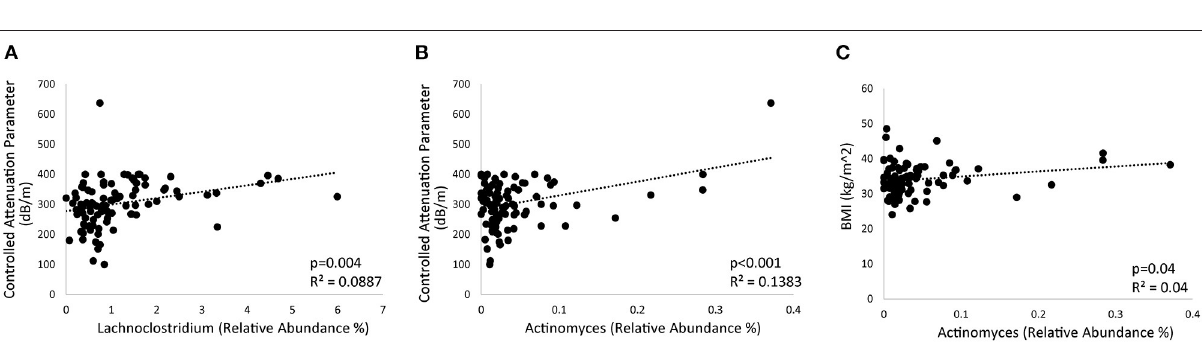
FIGURE 4 | Bacterial genera associated with hepatic steatosis and weight. (A,B) Regression plots showing the correlation of (A) Lachnoclostridium and (B) Actinomyces with hepatic steatosis as measured by controlled attenuated parameter (CAP). (C) Regression plot showing the relationship between Actinomyces and